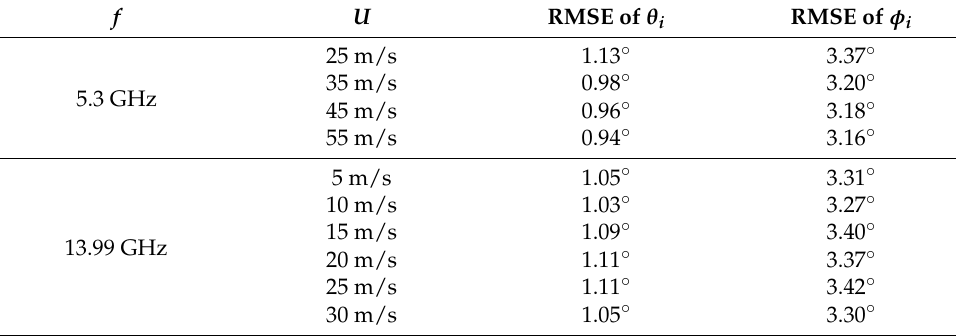
Table 4. Results of 100 realizations of the 5.3 GHz and 13.99 GHz datasets using the CNN